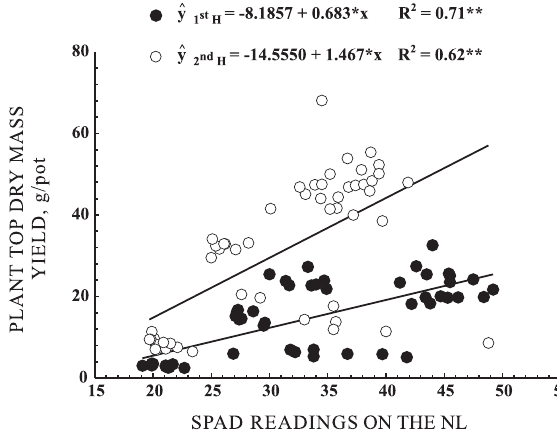
grass.Figure 7. Relationship between plant top dry mass yield and SPAD readings taken on the newly expanded lamina leaf (NL), in the first ( ) and second ( ) growth of the ‘Mombaça’